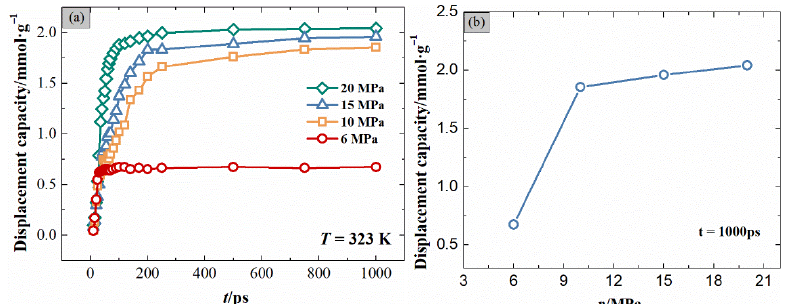
Figure 5. The displacement capacity of CH 4 by CO 2 : ( a ) displacement capacity at different pres- sures; ( b ) displacement capacity as a function of pressure. Figure 6 shows the displacement process with p = 20 MPa and T = 323 K at different times. The figure indicates that as time goes by, the CO 2 molecules on the left side grad- ually enter the slit and are gradually absorbed in the pores and the surface of the kerogen matrix. CO 2 molecules occupy the adsorption sites of CH 4 , and the adsorbed CH 4 mole- cules are replaced from the shale reservoir. Then, the free-state CO 2 molecules displace the desorbed CH 4 molecules from the nanoscale pores. Figure 6. The displacement process of CH 4 by CO 2 with p = 20 MPa and T = 323 K. Figure 7 plots the displacement efficiency as a function of pressure. It can be seen that as the injection pressure increases from 6 MPa to 10 MPa, the displacement efficiency in- creases by 44.4%. However, when the injection pressure is larger than 10 MPa, the increas- ing tendency of the displacement slows down. The displacement efficiency only increases by 7.0% , as the pressure increases from 10 MPa to 20 MPa. That means a further increase in the injection pressure is of little significance for enhancing shale gas recovery.